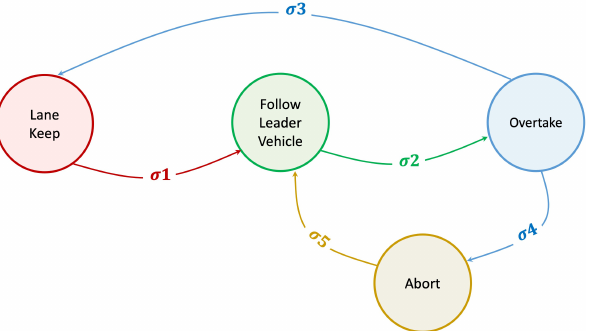
Figure 4. Simple Finite State Machine for Autonomous Vehicle Overtaking